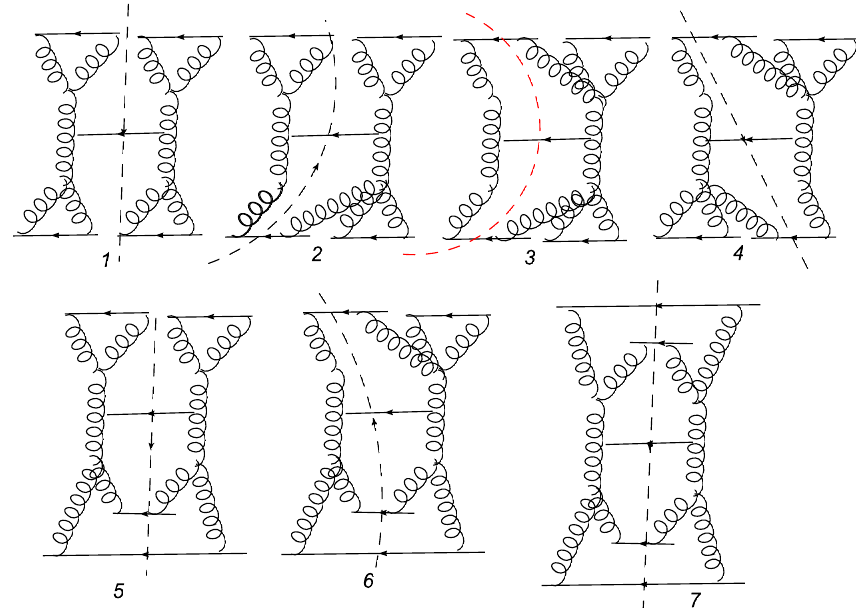
Fig. 12 Cut amplitudes for AB scattering with two reggeons attached to each participant and vertices reduced in the kinematics